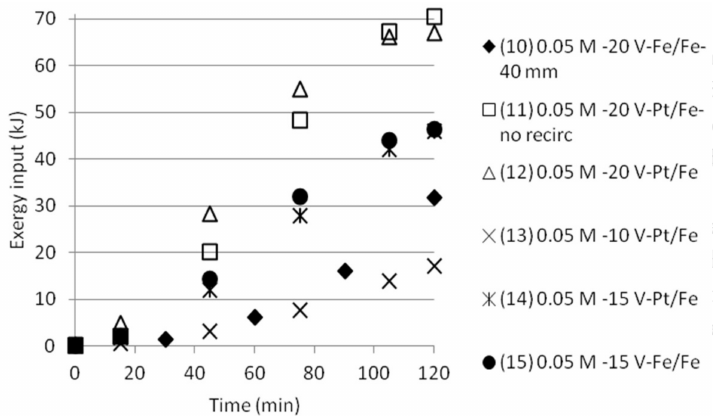
Figure 13. Cumulative exergy input in kJ as function of time for tests with five